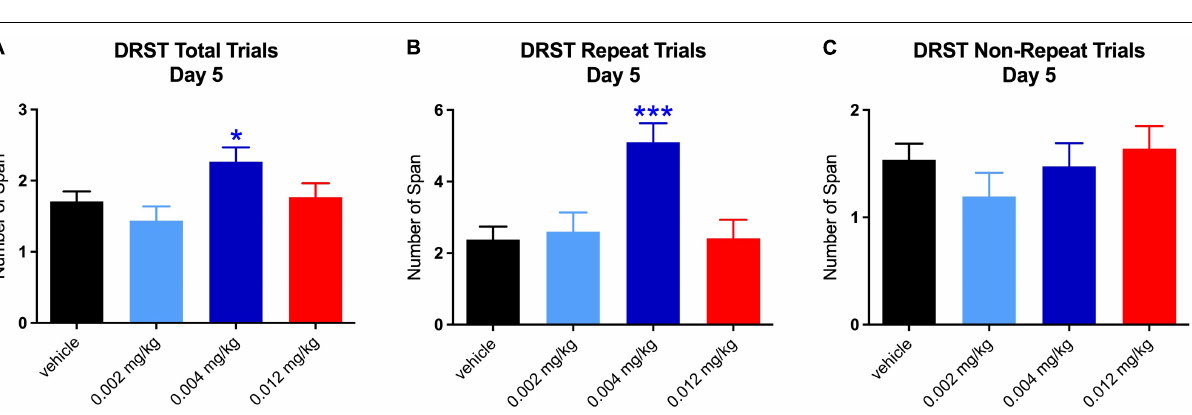
FIGURE 4 | Effect of PF-6294 on DRST Spatial Performance on Day 1. (A–C) The increase in total span on day 1 at the middle dose was driven by increases on both repeated (* p = 0.040) and non-repeated trials (* p = 0.019). Error bars = SEM.